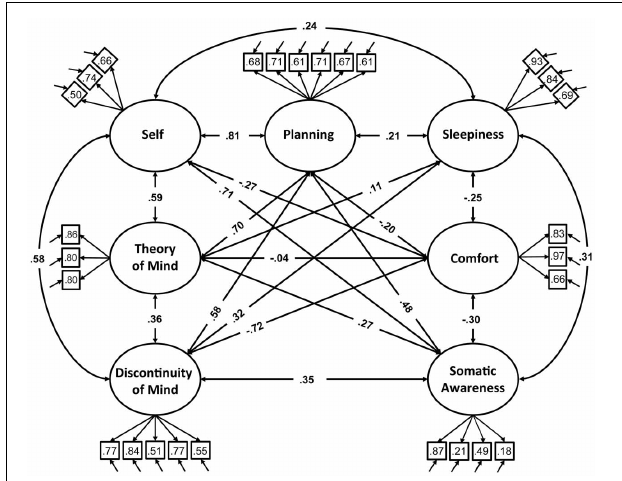
FIGURE 1 | Path diagram of the specified resting-state cognition model tested in CFA. Pathsbetweenfactors (ovals) representfactorial correlations. Numbers within squares indicate the standardized loadings of the particular item on its factor and residuals are depicted by the short single-headed arrows pointing towards items.